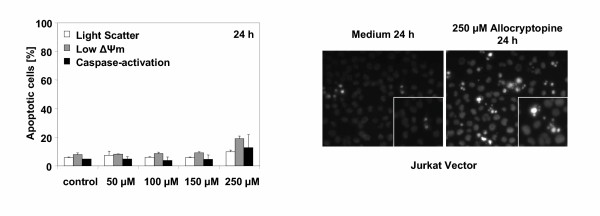
Allocryptopine fails to induce apoptosis at concentrations below 250 μM. Allocryptopine-induced apoptosis was quantified by flow cytometric analysis using light scatter characteristics (white bars), measurement of mitochondrial membrane potential Δψm (grey bars) and the activation of caspase-3 (black bars) upon treatment of Jurkat Vector cells for 24 h with medium or 0, 50, 100, 150 and 250 μM allocryptopine. Data show means ± SD (n ≥ 3) (left panel). Fluorescence microscopy upon combined staining with Hoechst33342 and propidium iodide staining of cells treated with 250 μM allocryptopine for 24 h showed increased numbers of cells with apoptotic morphology upon treatment (right panel).